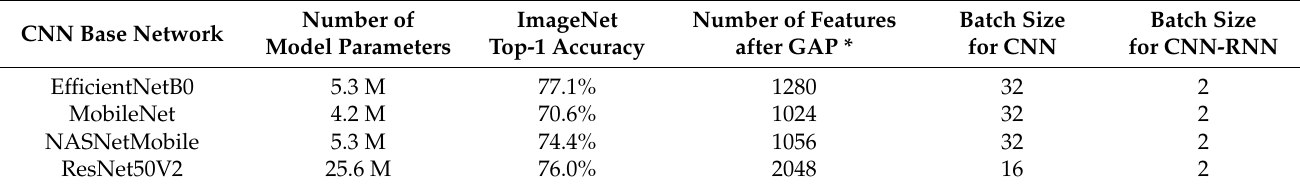
Table 4. The comparison of base deep CNN